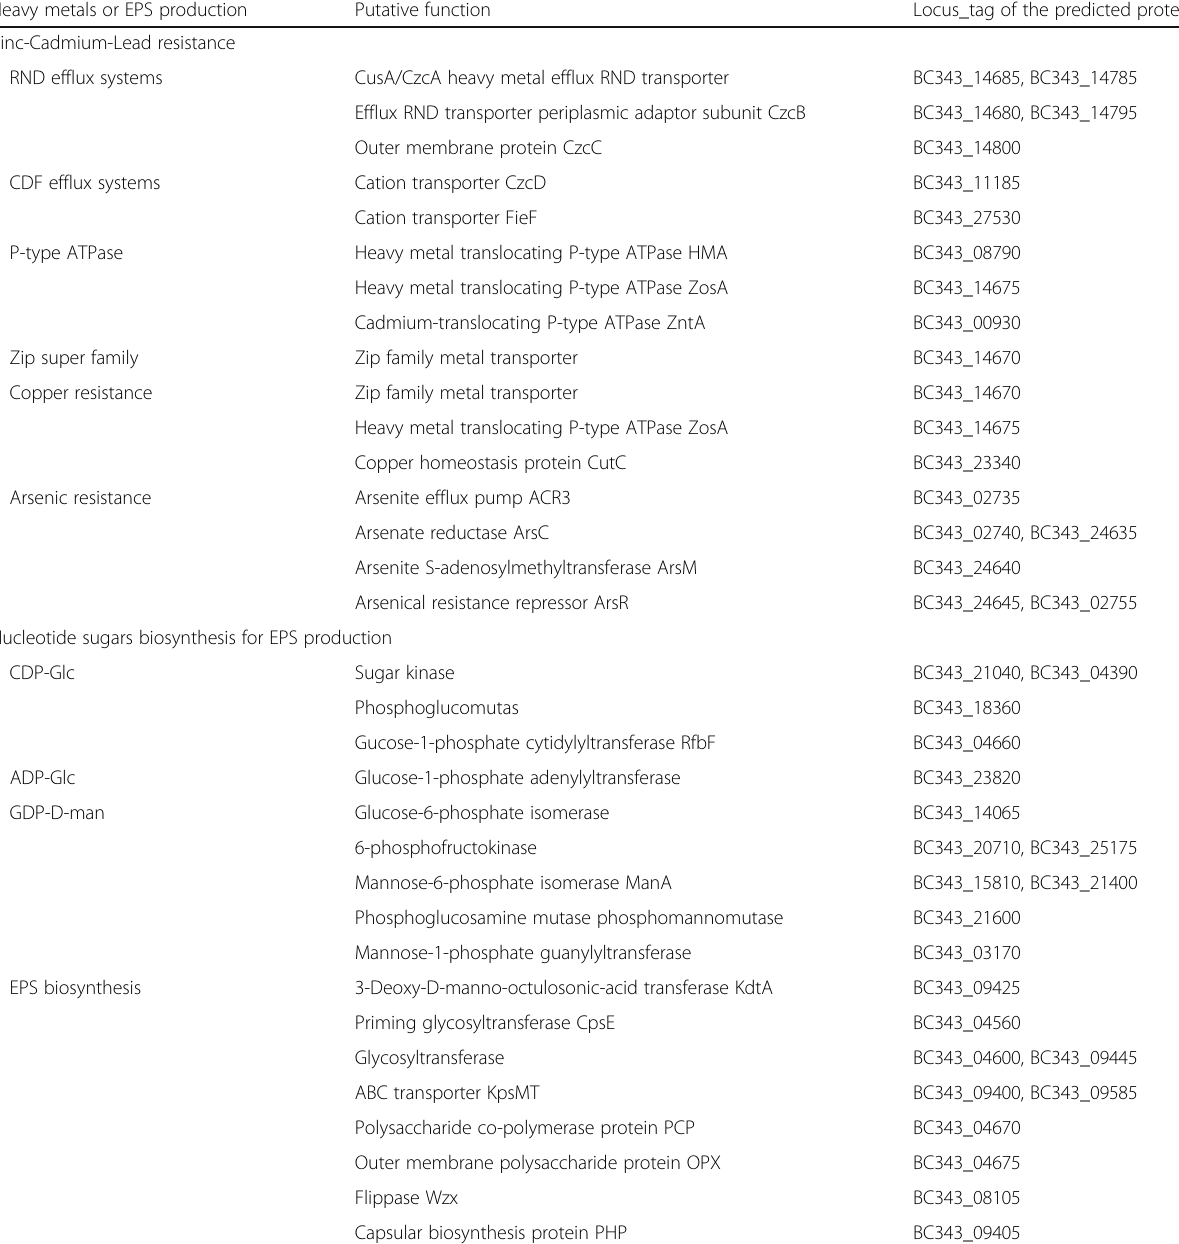
categories is summarized in Table 4. The graphical genome map is provided in Fig. 5. Table 5 Putative protein involved in heavy metals resistance and EPS production Heavy metals or EPS production Putative function Locus_tag of the predicted protein Zinc-Cadmium-Lead